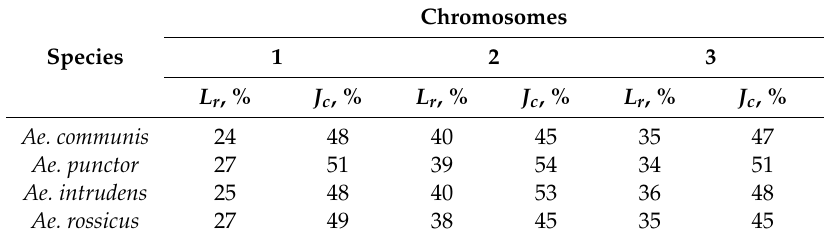
Table 2. Quantitative characterization of the chromosomes of Ae. communis , Ae. punctor , Ae. intrudens , and Ae. rossicus mosquitoes ( L r , %, relative chromosome length and J c , %, centromeric index).